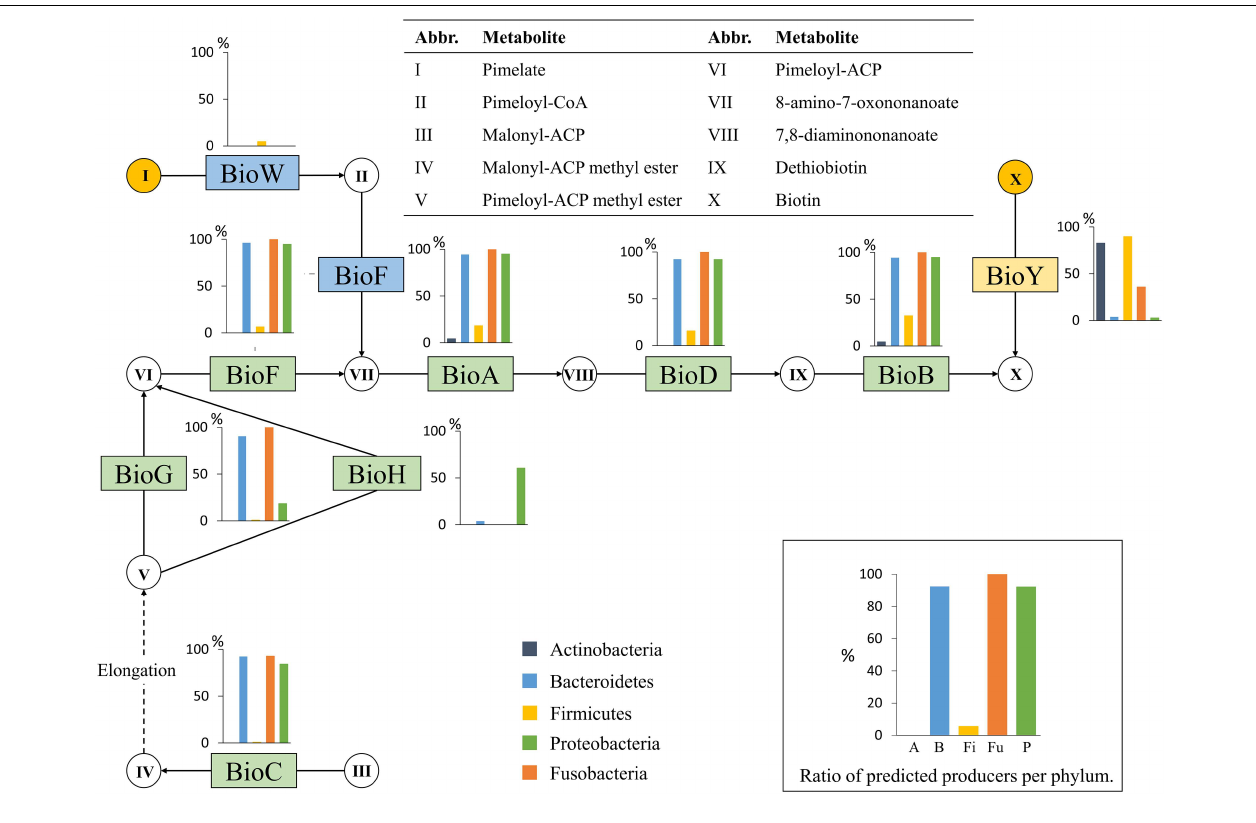
FIGURE 1 | Biotin biosynthesis. The biotin biosynthesis subsystem contains 9 functional roles (Supplementary Table 2) and 10 metabolites. Functional roles are represented by rectangles. The major biosynthesis routes are colored green, alternative routes are blue, salvage routes are red, and known transporters are yellow. Metabolites